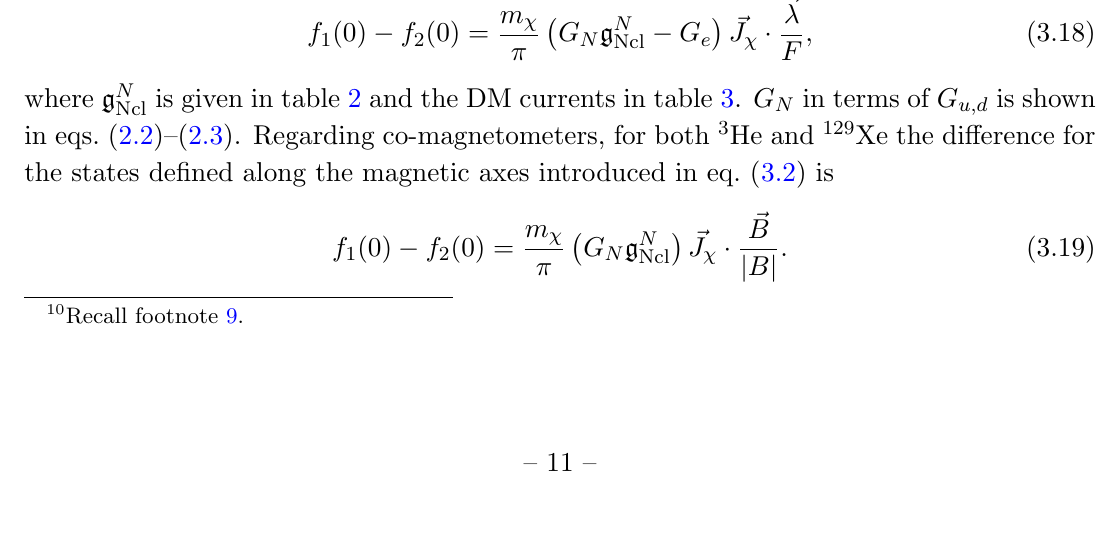
For the alkali elements, the states of eq. (3.1) are eigenstates of total angular momen- tum, F , the sum of the nuclear and electronic contributions. The evaluation of their matrix elements yields,